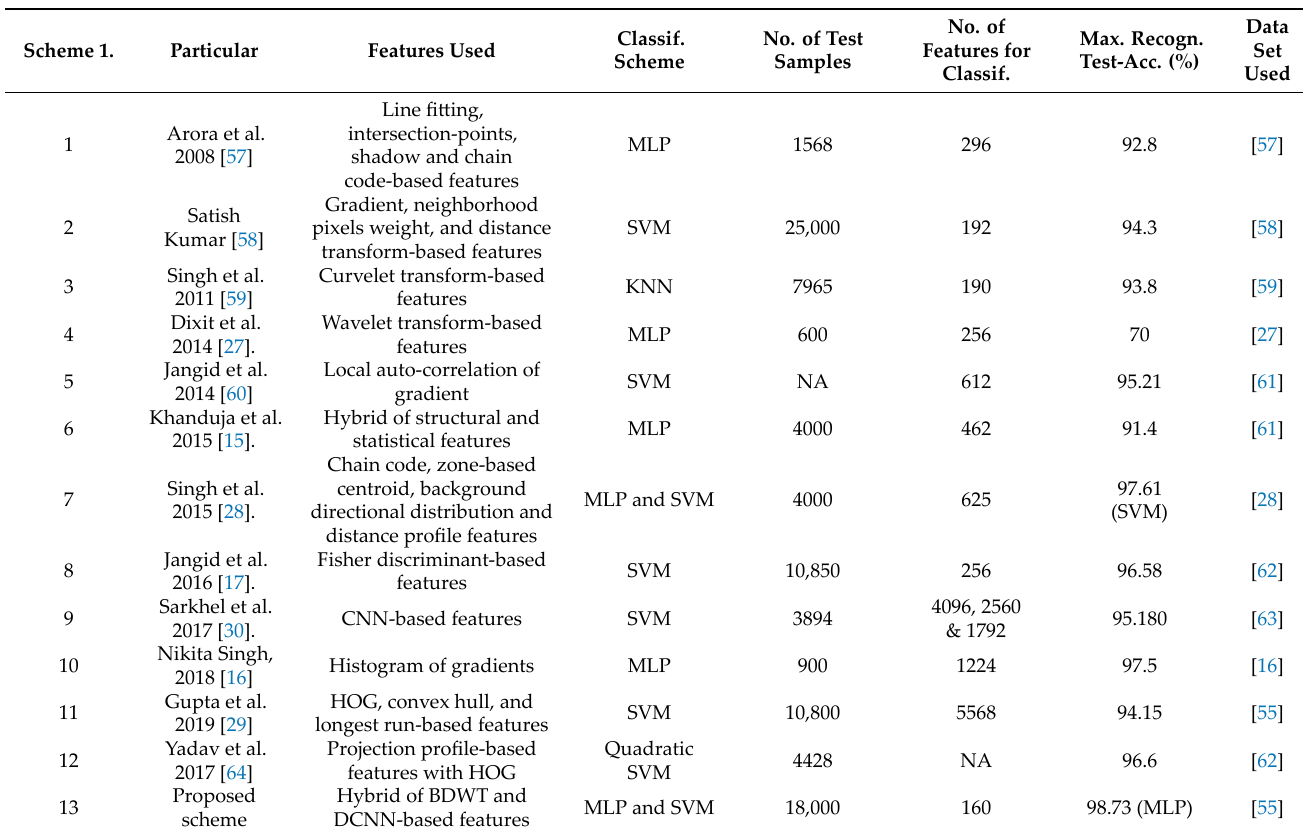
Table 17. Summary of previous work done in the field with the proposed